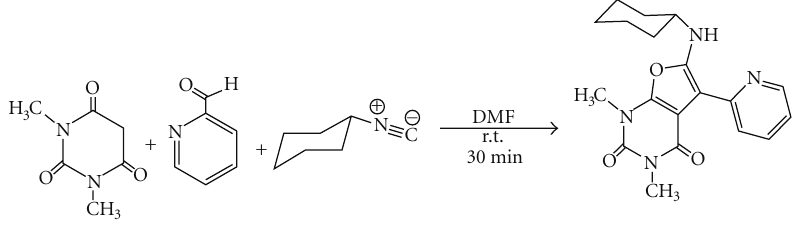
Figure 1: Synthesis route of CDP